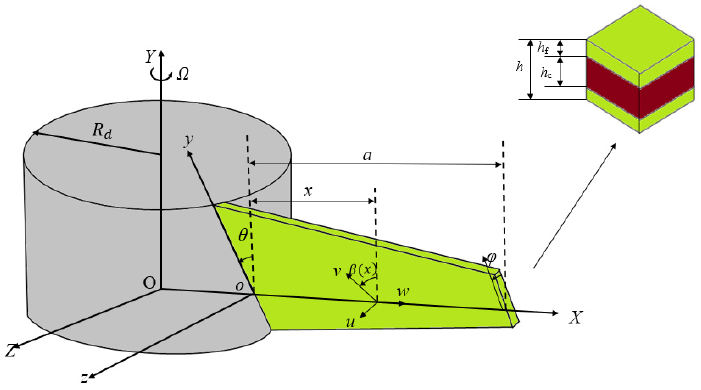
Figure 1. A rotating pre-twist blade with a setting angle attached to a rigid body.